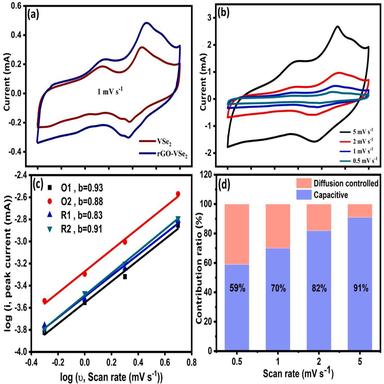
(a) CV curves of pure VSe2 and rGO-VSe2 nanohybrid at 1 mV s−1; (b) CV curves of rGO-VSe2 at different sweep rates; (c) log (i) vs. log (v) plots at specific peak currents; and (d) the corresponding capacitive contributions at different scan rates.